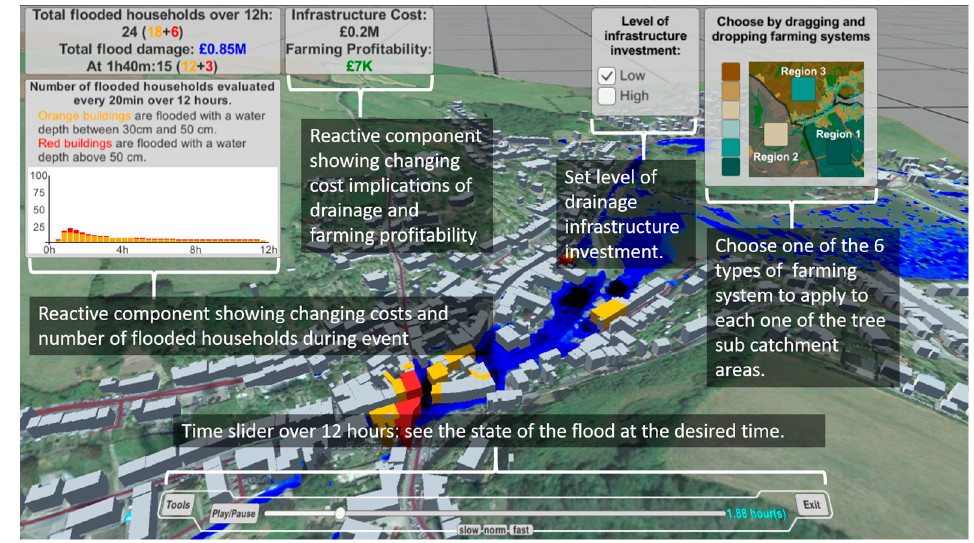
Figure 4. The user inputs as seen in the Serious Game interface.